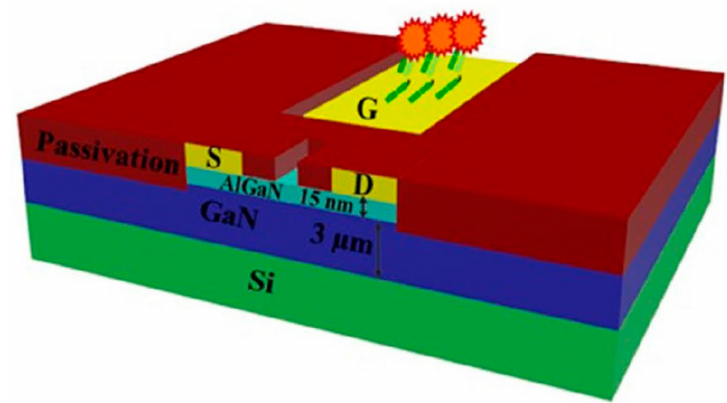
Figure 5. Schematic model of the AlGaN / GaN high electron mobility transistor (HEMT) with the active channel and gate electrode, which is functionalized with receptors, are passivated separately. Only these two components of this FET biosensor are exposed to the analytes